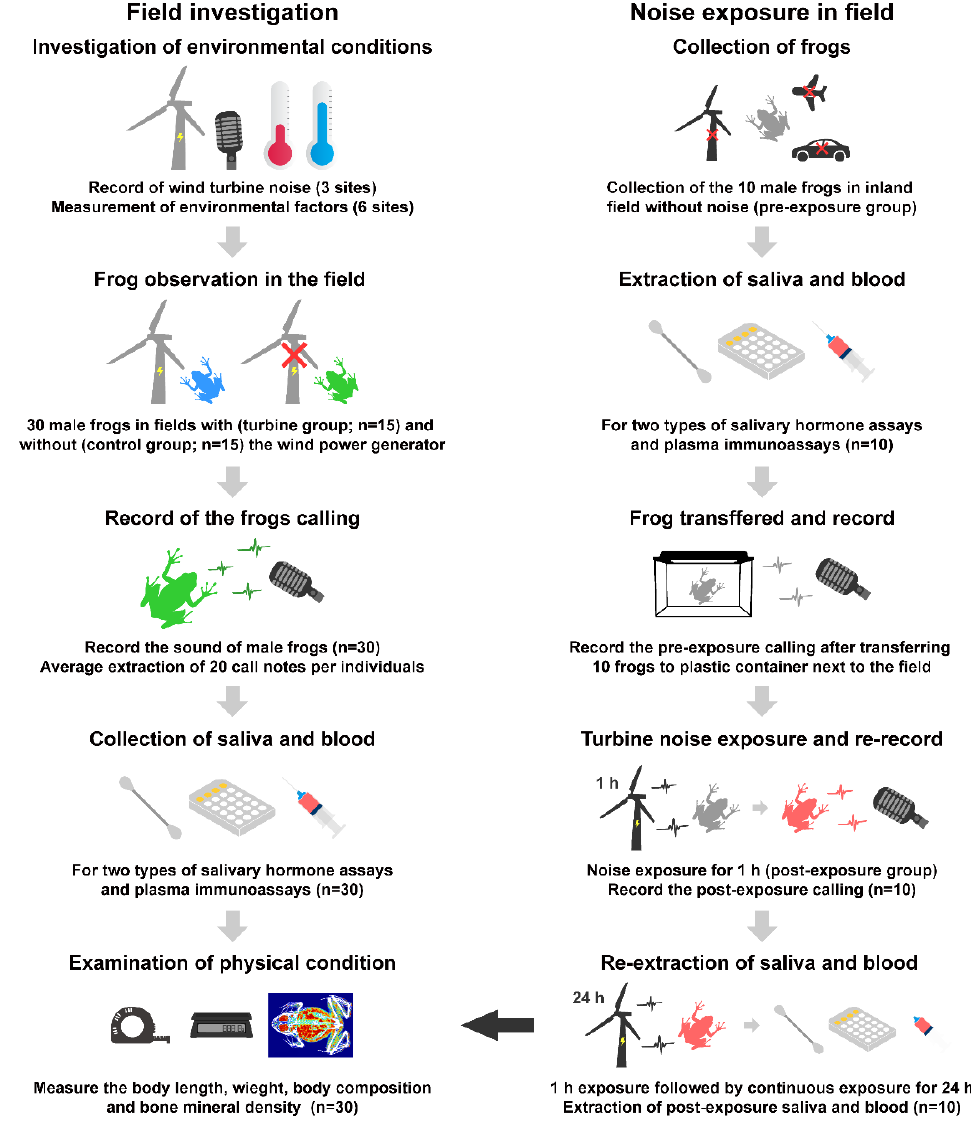
Figure 2. Experimental summary of this study. The figure includes the design of the experiment, number of frogs collected, and the number of samples used. The field investigation was conducted in Yeonggwang-gun and was conducted in three sites of paddy field areas with wind power generators and three sites of paddy field areas without wind power generators. The noise exposure experiment was conducted in Gongju-si, where the noise of airplanes, traffic, and wind power generators was unprecedented.